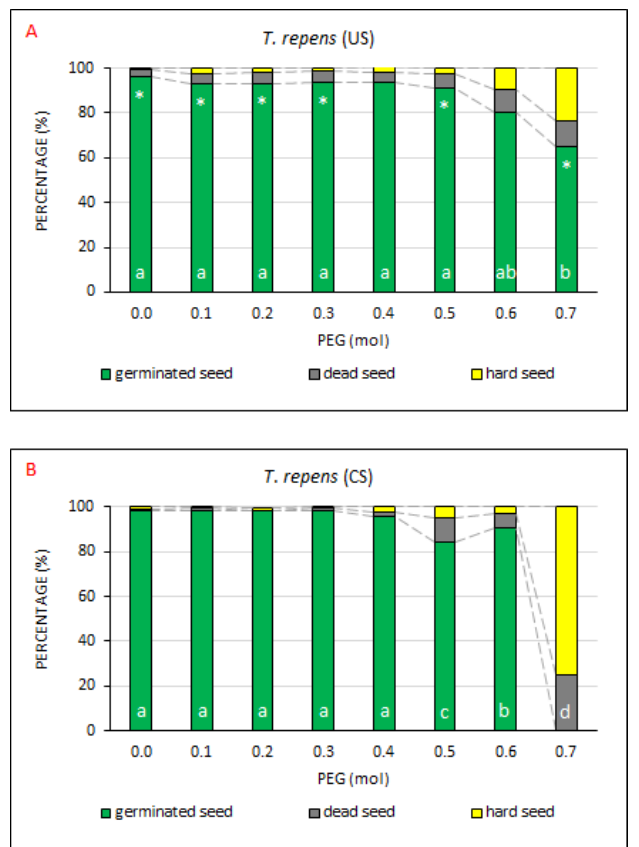
Figure 8. The comparison of germinated, dead and hard seed percentages at drought simulation degrees. Average percentages of GS, DS and HS for T. repens , the ( A ) US (uncoated seeds; n = 4 ± SE) and ( B ) CS (coated seeds; n = 4 ± SE) treatments at the respective PEG concentrations = 0.0–0.7 mol. Different lowercase letters indicate a significant difference (ANOVA post-hoc Tukey’s HSD test; p < 0.05) between the percentage of GS values in the US and CS treatments. The * symbol rep- resents a significant difference in the percentages of GS values between US and CS at a specific PEG concentration.